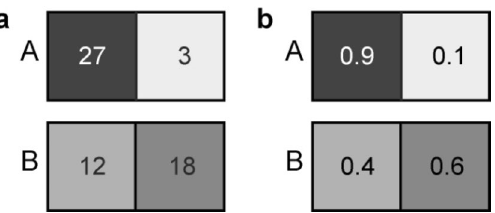
Figure 1. Two two-pixel images, A and B ( a ) and their corresponding probability density functions (PDFs) ( b